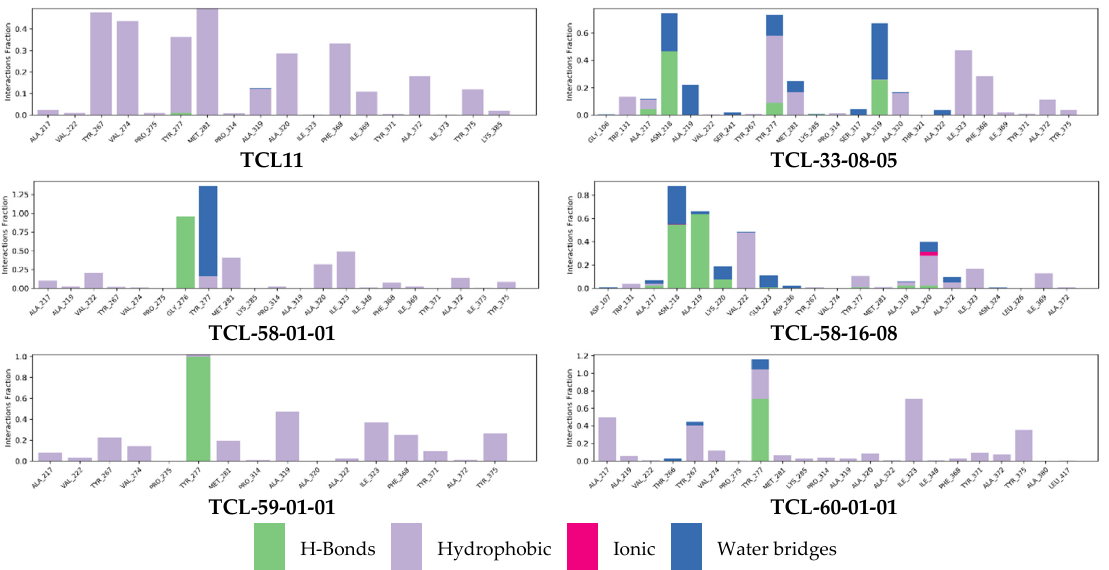
Table 8. Ensemble averages of the total and potential energies of complexes Pf ENR ‐ TCLx for TCL11 and selected virtual hits. Figure 11. Contribution of individual active site residues to inhibitor binding in Pf ENR-TCLx complexes present during MD simulations: HB (green); ionic interactions (magenta); hydrophobic contacts (purple); water bridges (blue).